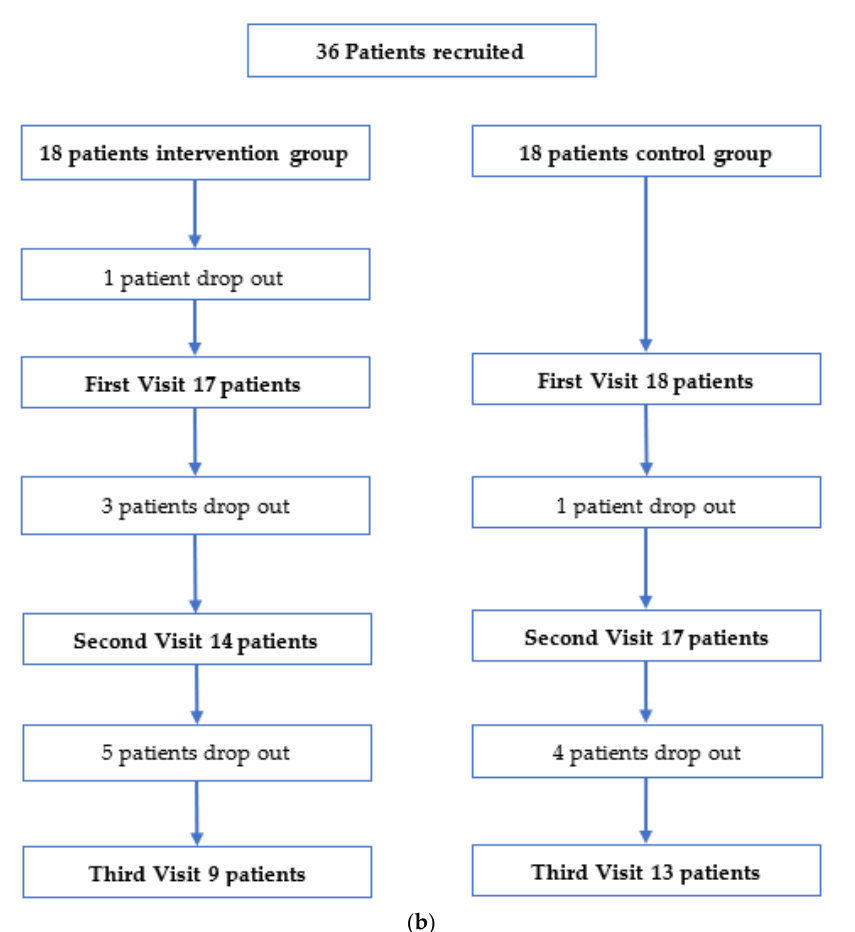
Figure 1. ( a ) . Study flow diagram: 6MW—6 min walk test; BNP—brain natriuretic peptide. ( b ) . Figure 1. ( a ). Study flow diagram: 6MW—6 min walk test; BNP—brain natriuretic peptide. ( b ). Patient Patient recruitment.